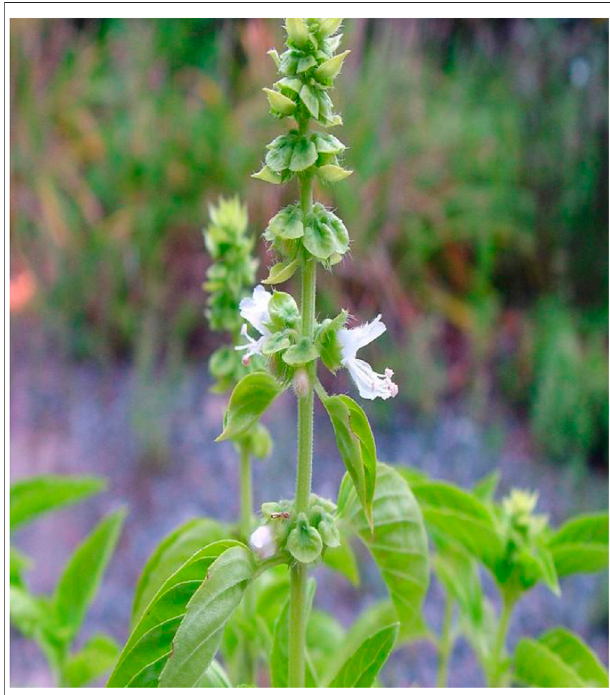
FIGURE 1 | Natural view of Ocimum basilicum